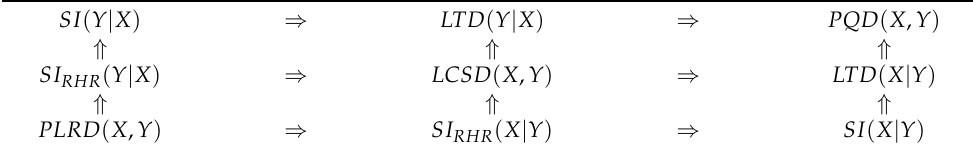
Table 3. Relationships among reversed positive dependence